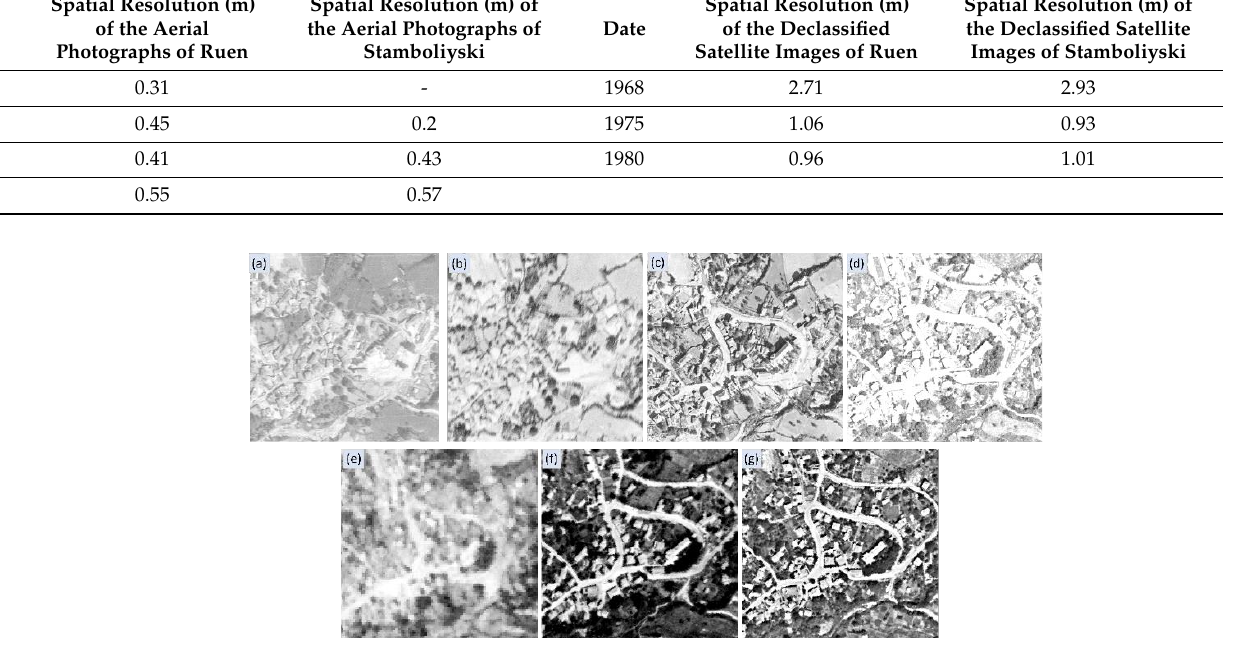
Figure 12. Comparisons of spatial resolutions of Ruen aerial photographs ( a ) 1945, ( b ) 1952, ( c ) 1965, and ( d ) 1975 and ( e ) 1968 Corona image, ( f ) 1975, and ( g ) 1980 Hexagon images.